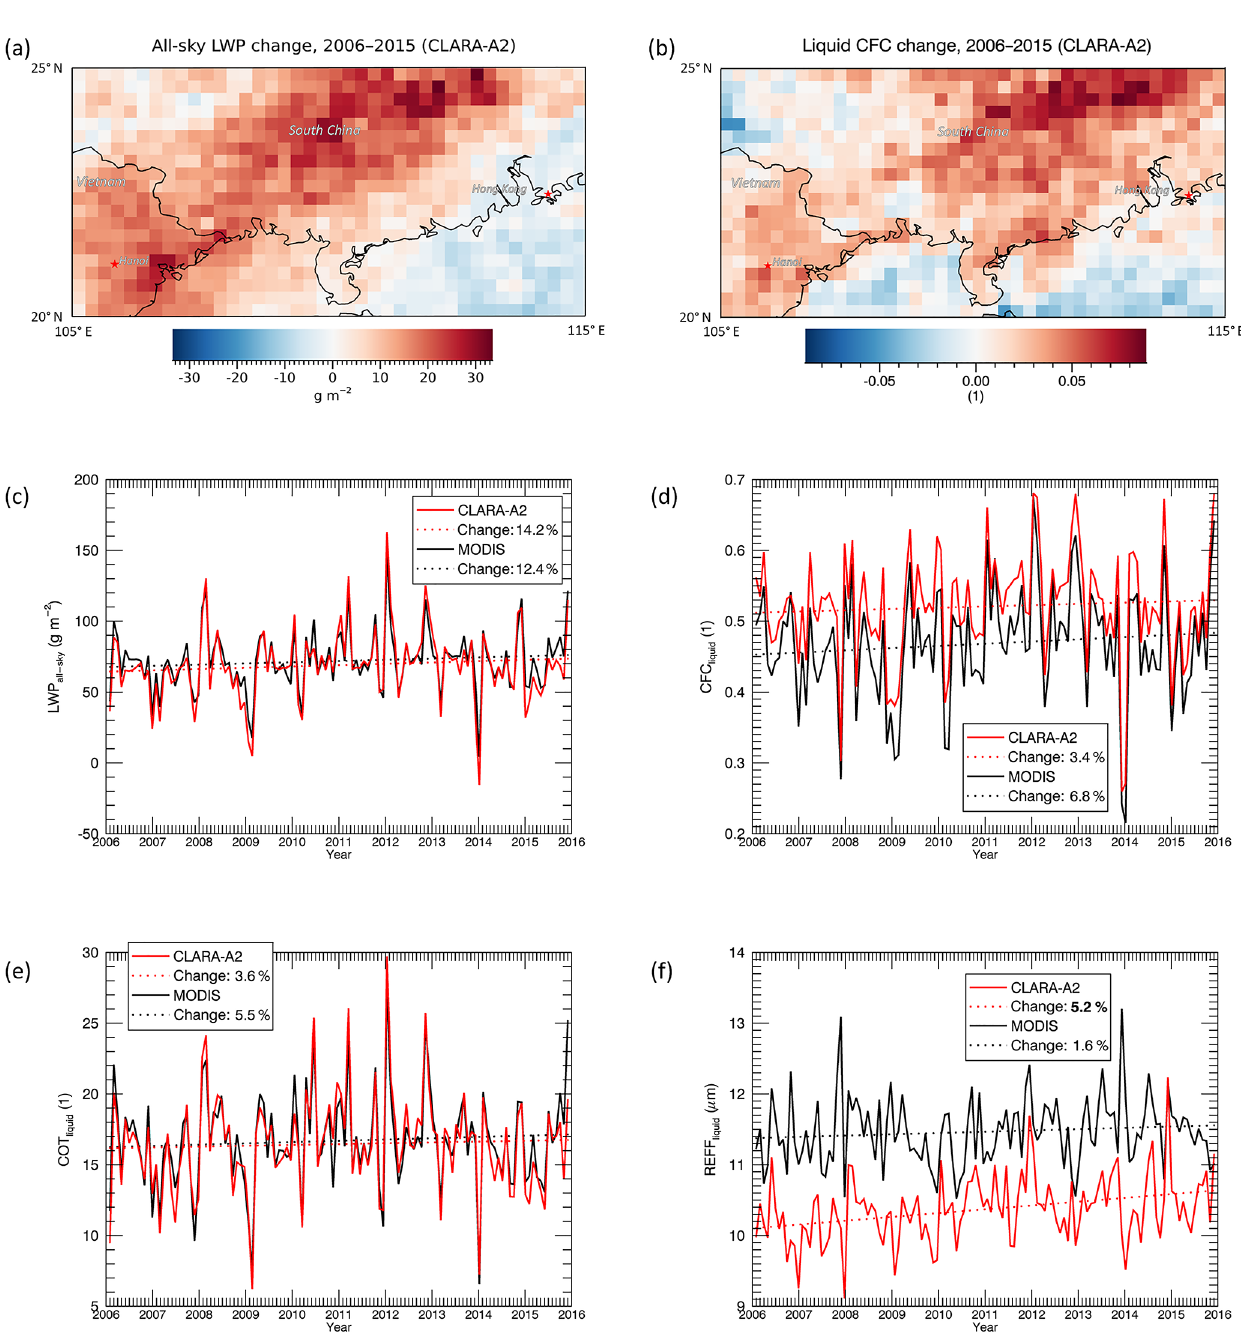
Figure 8. Changes in liquid cloud properties over southern China from 2006 to 2015, based on CLARA-A2 and MODIS data. (a, b) Spatial distributions of changes in all-sky LWP and liquid CFC based on CLARA-A2 data. Spatially averaged monthly deseasonalized values of all- sky LWP (c) , liquid CFC (d) , liquid COT (e) and REFF (f) . Percent changes during the period examined are also shown, with the statistically significant ones (only CLARA-A2 liquid REFF) indicated in